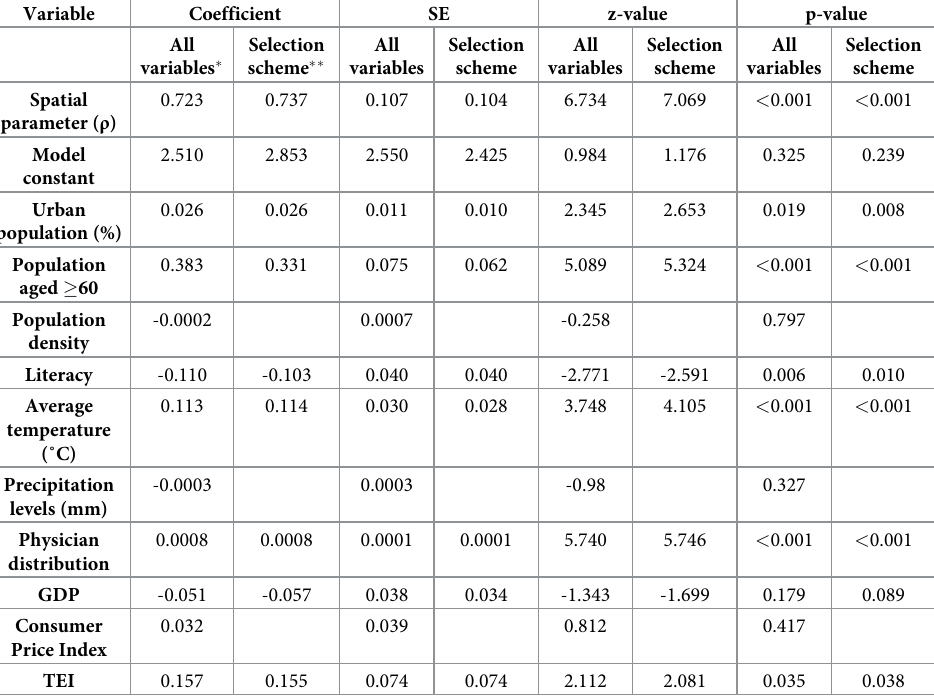
Table 2. Spatial lag models estimated via maximum likelihood to predict log-transformed COVID-19 case distri- bution between Iranian provinces (model including all variables and model obtained through a selection scheme).